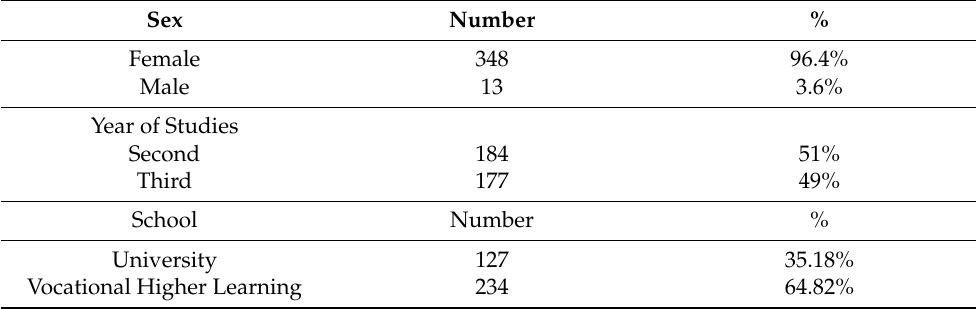
Table 1. Demographic profile of participants (N =